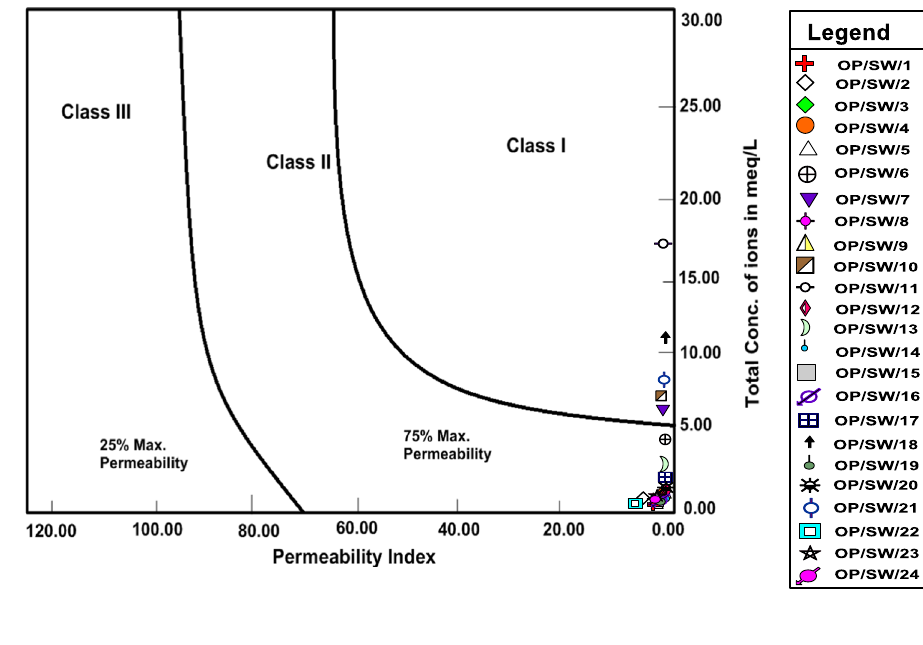
Fig. 6 Doneen’s (1964) Chart for P.I. values of surface water